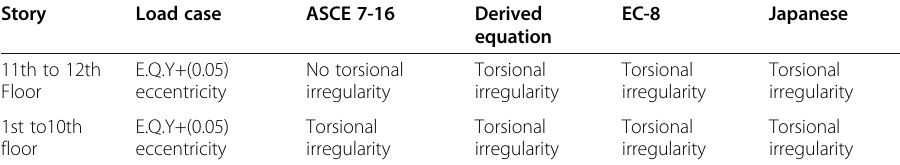
Table 9 Torsional irregularity check of 4th and 5th model due to ASCE 7-16, EC-8, Japanese, and derived equation